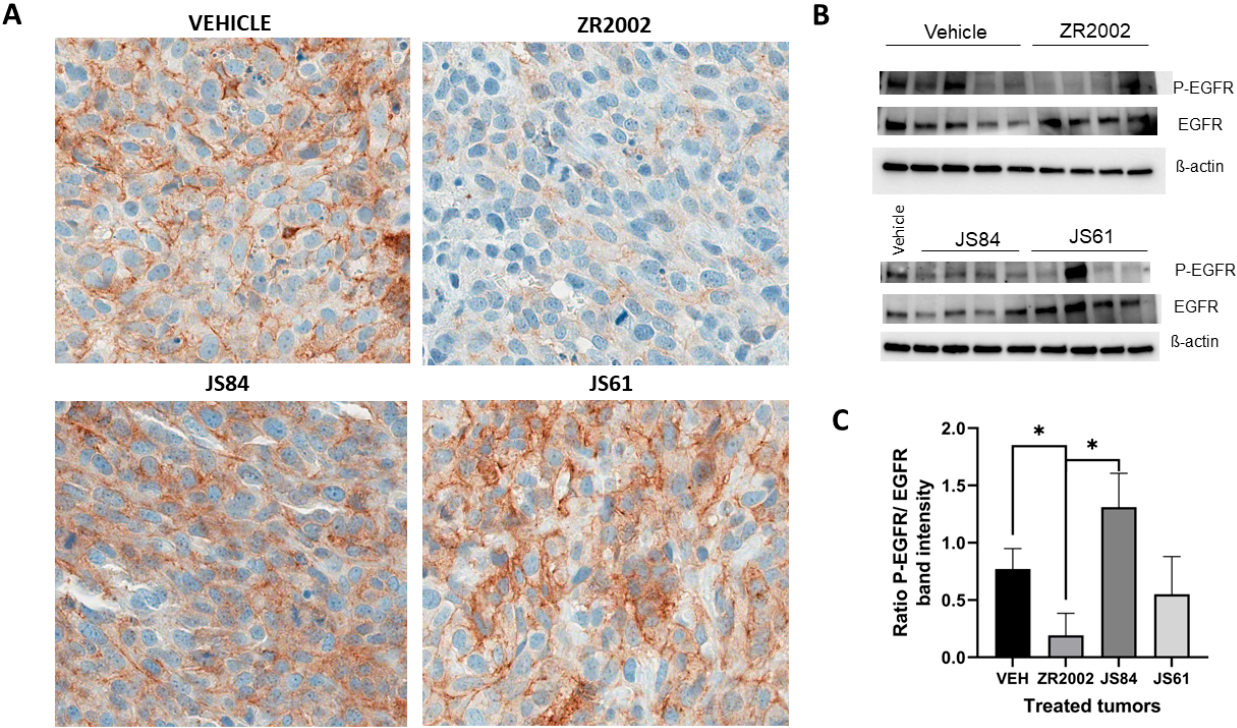
Figure 4. Immunohistochemistry and Western blot analysis of the effects of ZR2002, JS84 and JS61 on tumor tissues. ZR2002 decreases the phosphorylation of EGFR (P-EGFR). ( A ) Representative sections of Saos-2 tumors stained for P-EGFR. ( B ) Western blots for P-EGFR (Tyr 1068) and EGFR, where β -actin was used as internal control. Each band corresponds to different tumor lysates. ( C ) Quantification of Western blot: ratio of band intensity between P-EGFR and EGFR total protein. Data are expressed as means ± SEM. * p < 0.05 between the two groups.